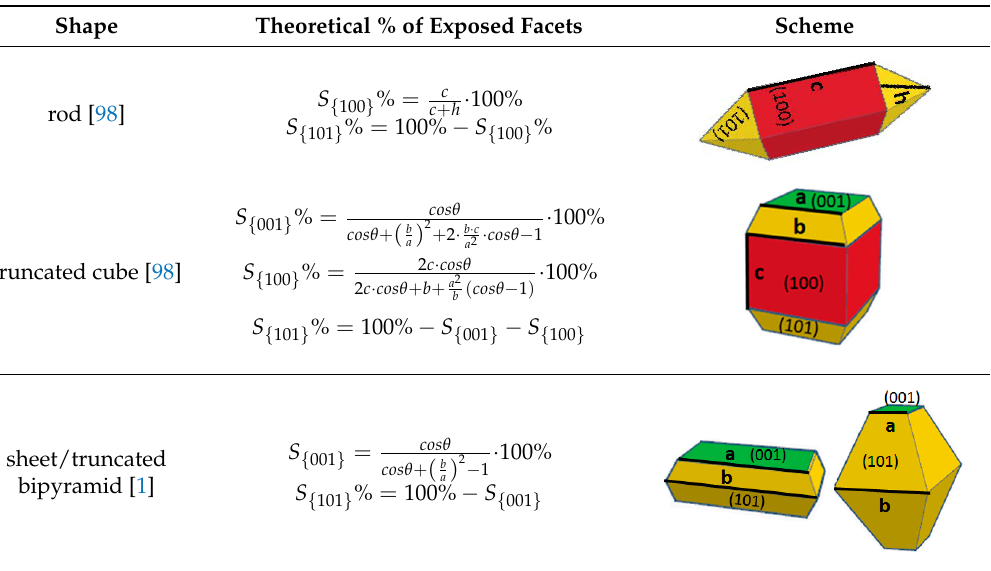
Table 6. Formulas enabling calculations of the percentage of exposed facets.